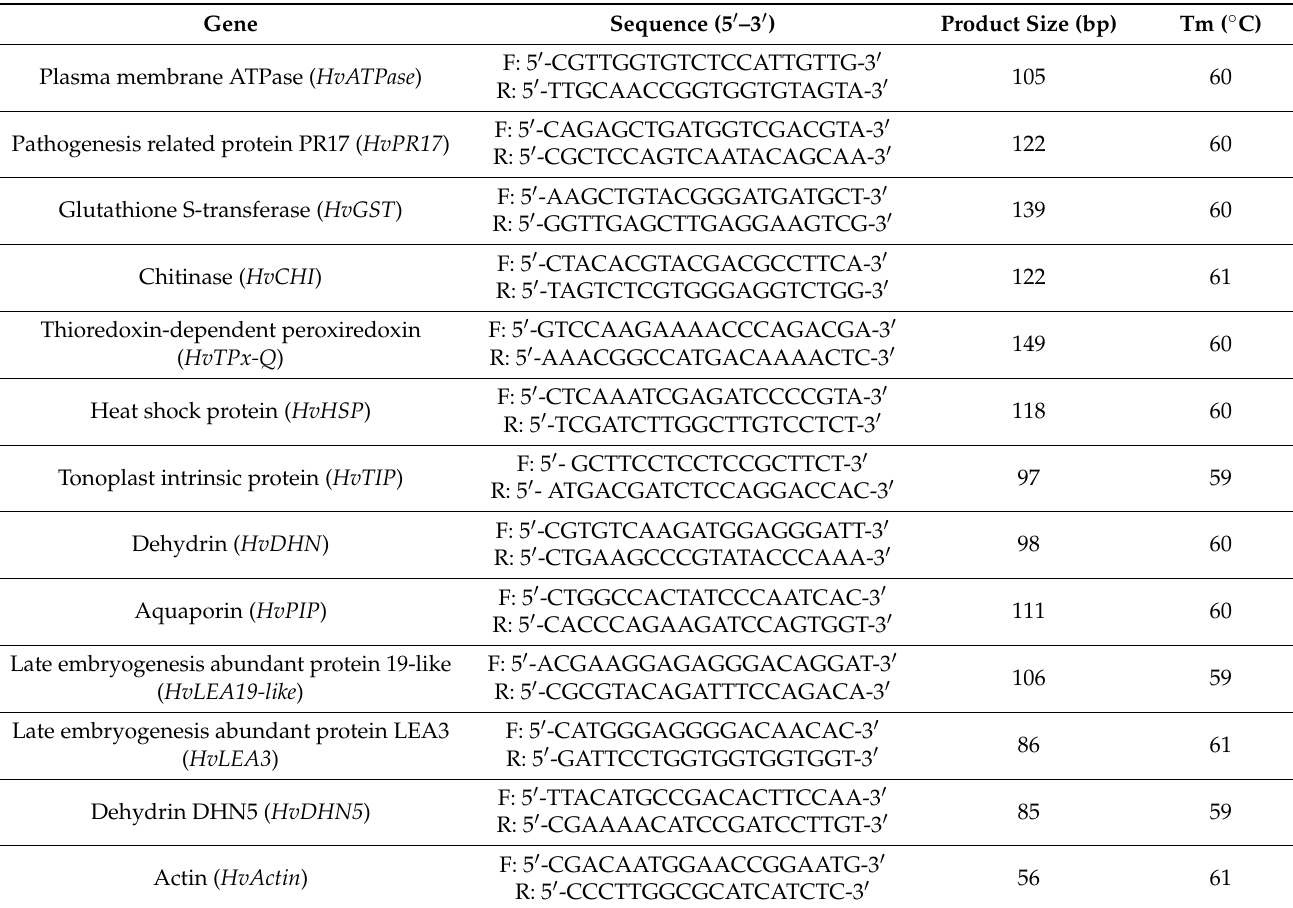
Table 4. Sequences of primers used for real time quantitative PCR